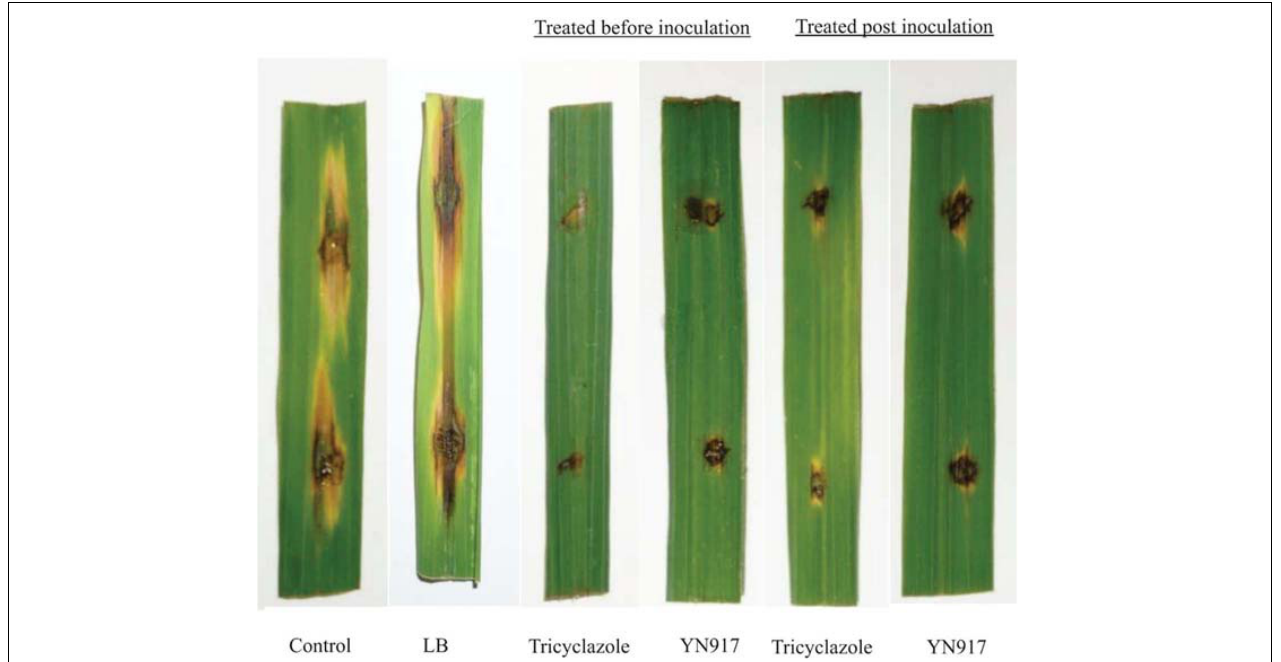
FIGURE 3 | Lesion development 5 days after inoculation with strain Bacillus cereus YN917 following protective and therapeutic droplet treatments.